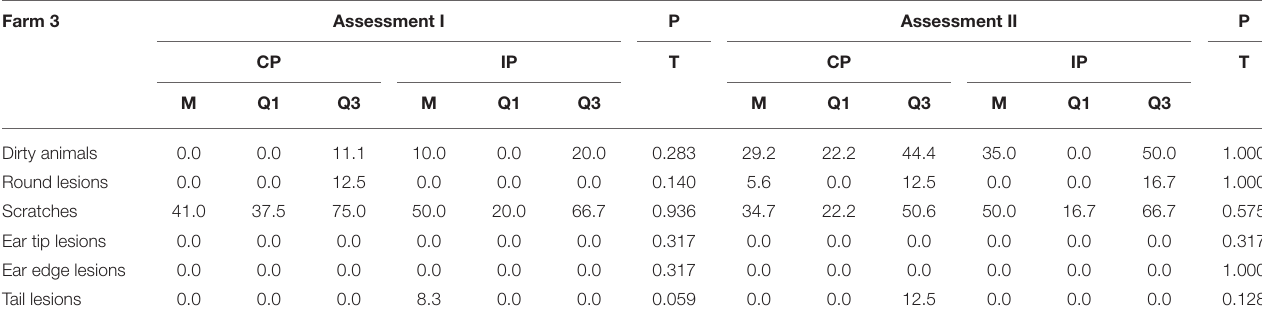
TABLE 9 | Prevalence of lesions and soiled pigs (median M, lower quartile Q1 and upper quartile Q3) for pigs in IP (improved pens) and CP (control pens) during assessments I (baseline) and II (middle of the fattening period) on Farm 3. Farm